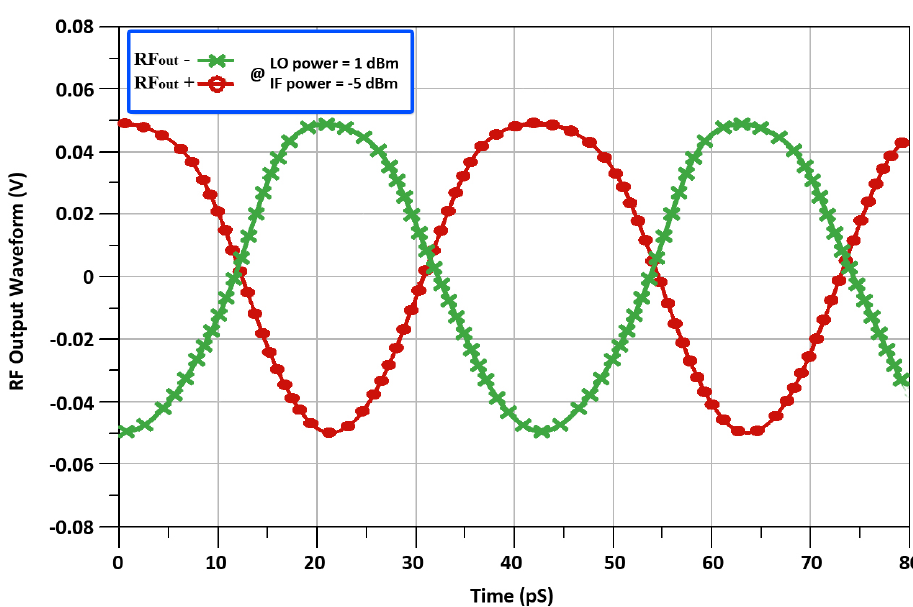
Figure 17. Output voltage